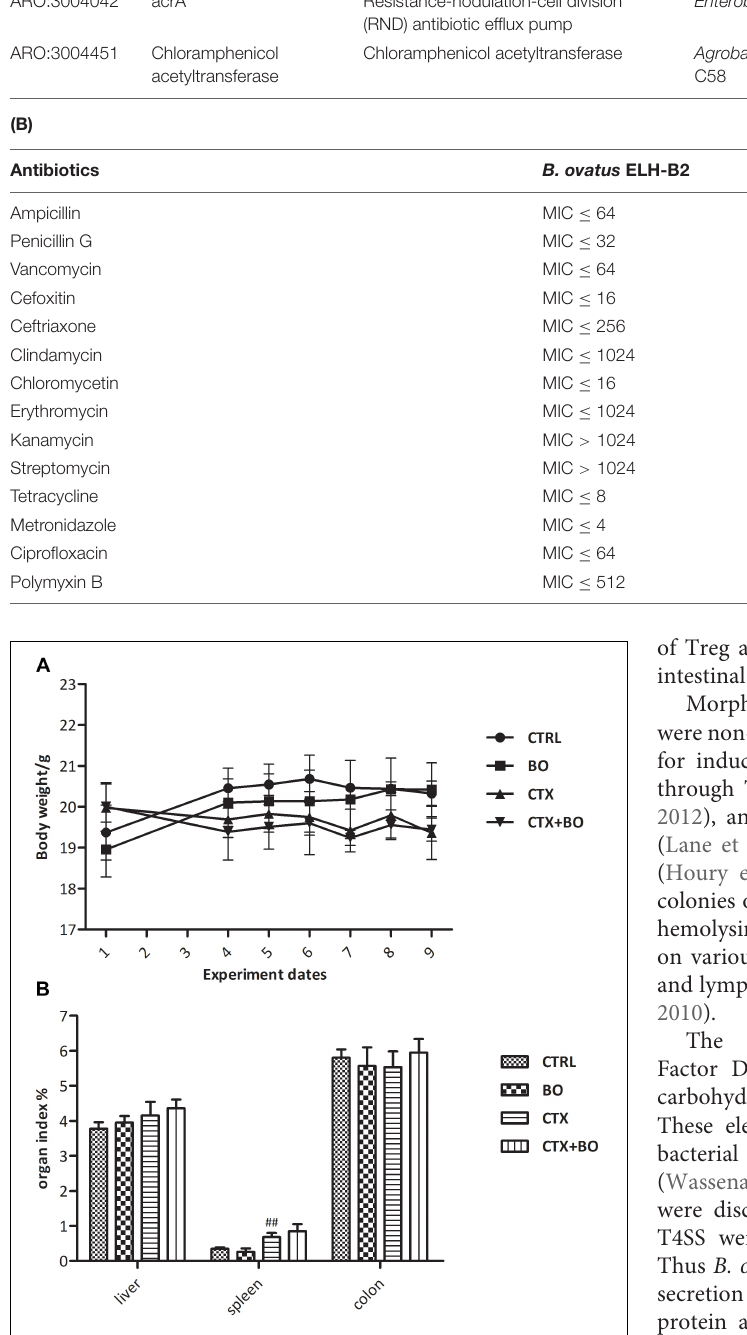
FIGURE 2 | Impact of B. ovatus ELH-B2 on (A) the body weight and (B) the organ indexes of immunocompetent and immunosuppressed mice. The organ indexes of the liver and spleen are expressed as the ratio of the corresponding weight of the organ and body, while the colon index is expressed as the colon length of each animal. Data are displayed as mean ± SD, “##” indicates statistically significant differences between the CTX + BO group and the CTRL group ( p <